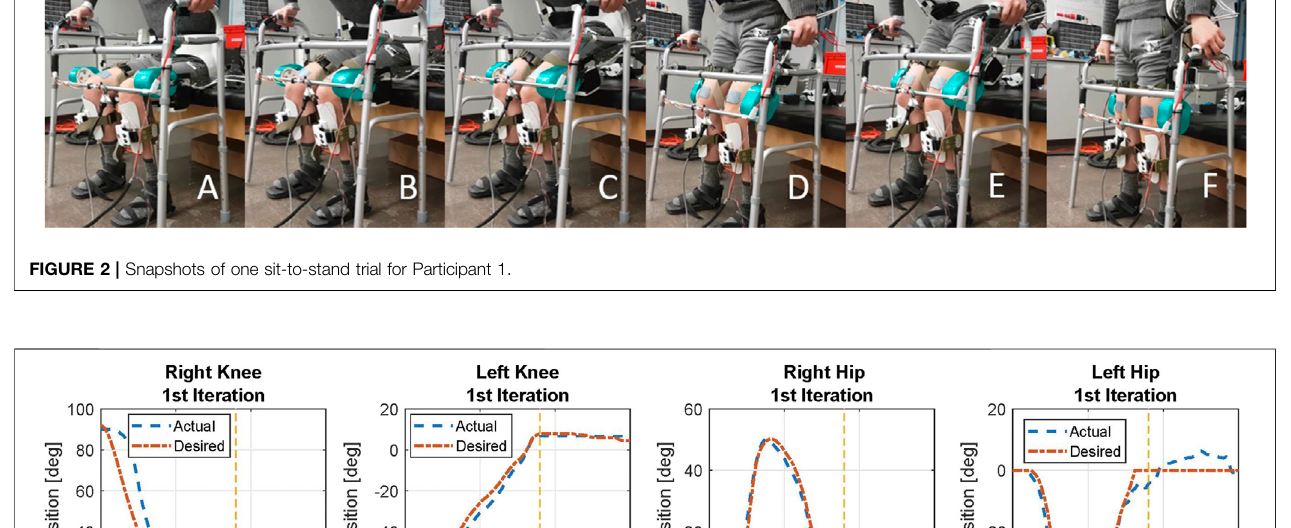
Frontiers in Robotics and AI |